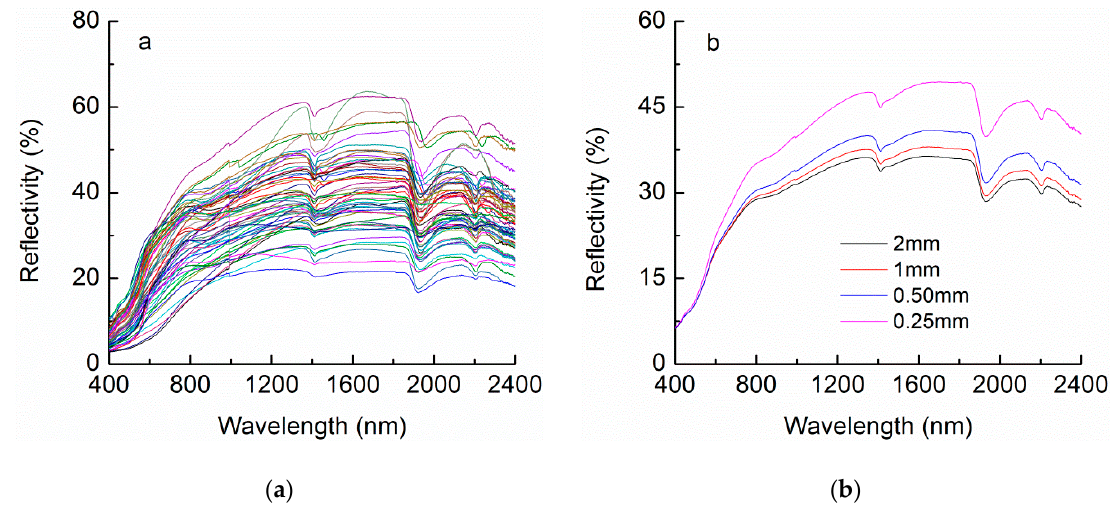
Figure 2. Spectral reflectance curves of soil: ( a ) 60 spectral reflectance curves of the total samples; ( b ) mean spectral reflectance curves of four particle sizes.